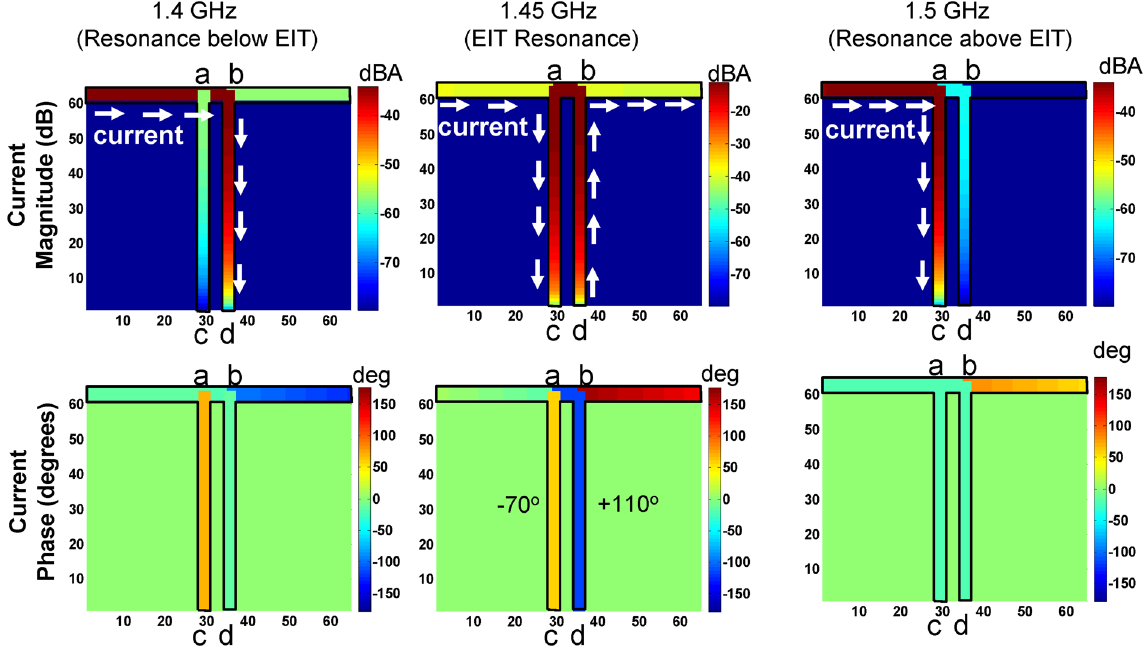
Figure 9. The current magnitude and phase distributions on the EIT double stub structure caluclated from the transmission line analytical model at three spectral resonance points.